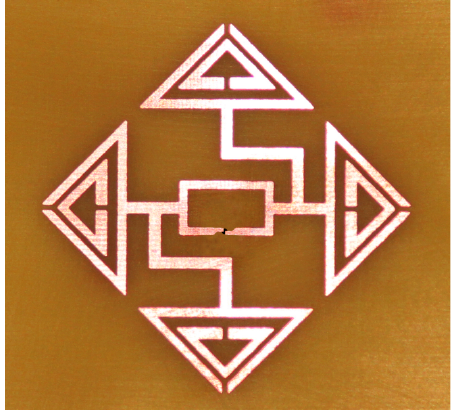
Figure 4: Photograph of the fabricated prototype RFID tag